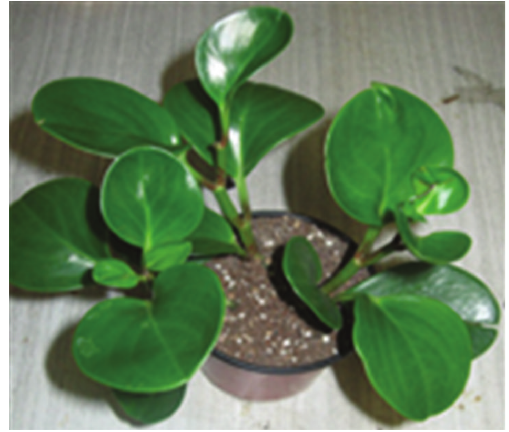
Figure 2: descoingsii x haworthioides plant for measuring the action